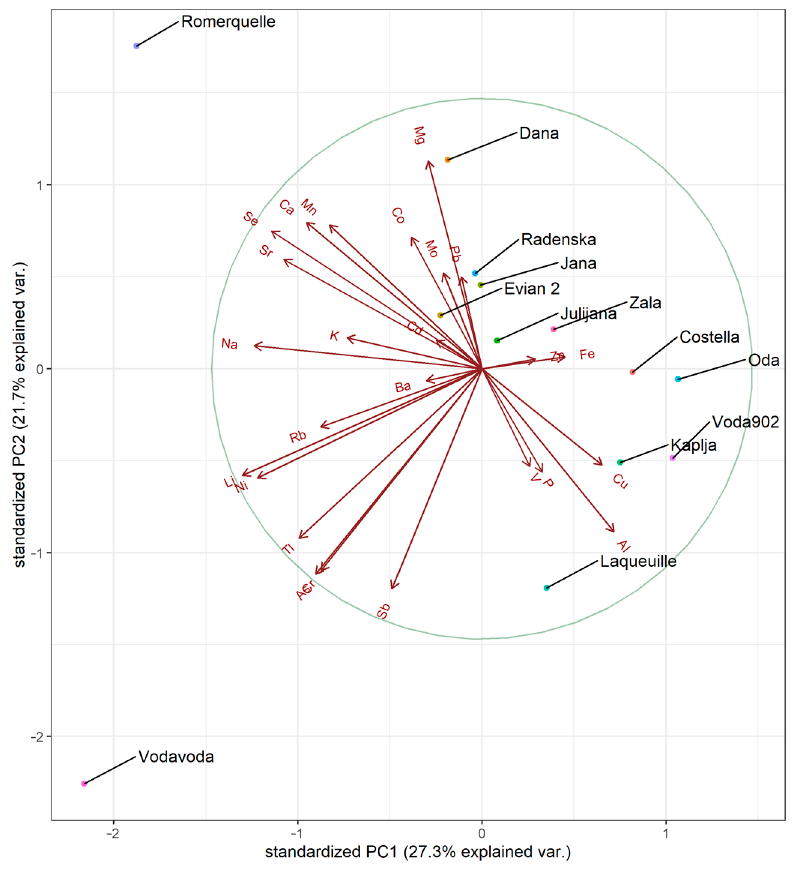
Figure 8. Biplot of the first two principal components axes from a PCA of elemental concentrations in bottled waters.